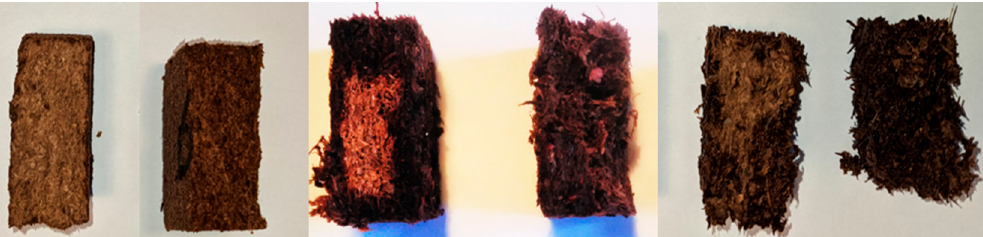
Figure 2. Water penetration over the cross section of the tested sample: fibre length 1.6 mm, wet and dry ( left ); fibre length 4 mm, wet and dry ( middle ); and fibre length 7 mm, wet and dry ( right ).